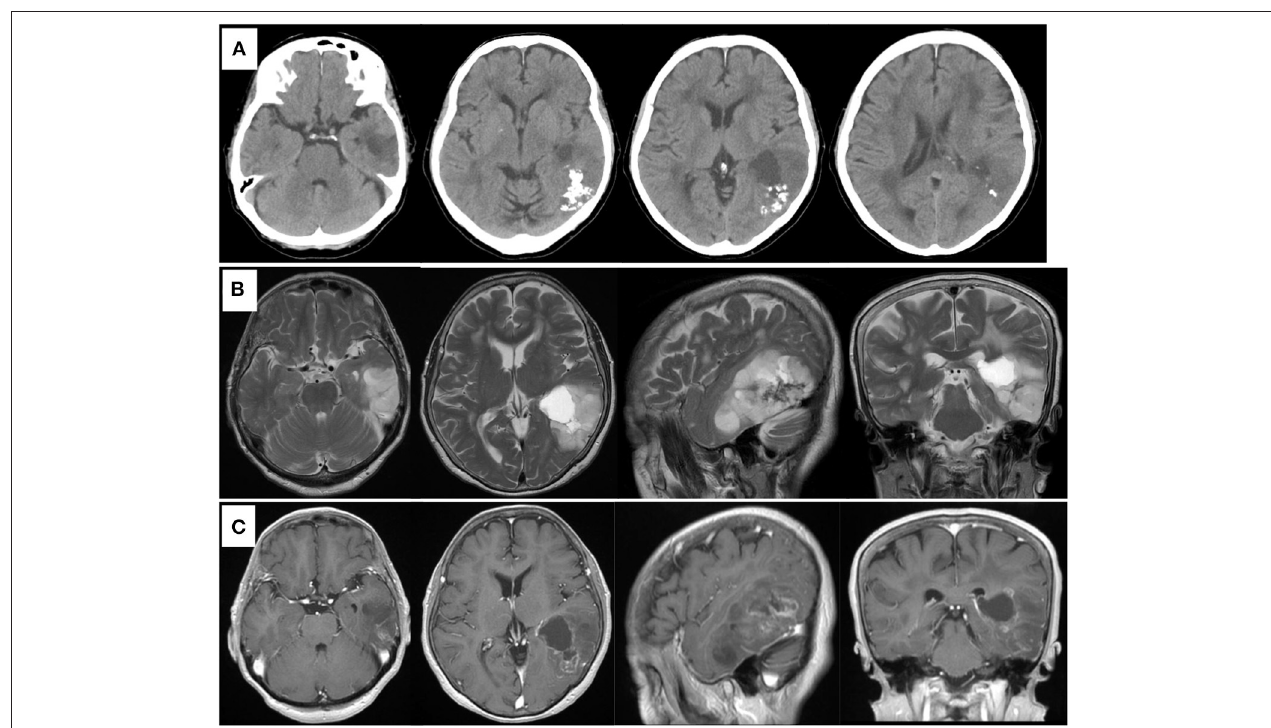
FIGURE 1 | Preoperative computed tomography showing calcified and cystic lesions in the left temporal lobe (A) . MR images showing high intensity in the left temporal lobe on T2-weighted image (B) and heterogeneous enhanced lesion on gadolinium-enhanced T1- weighted image (C) .